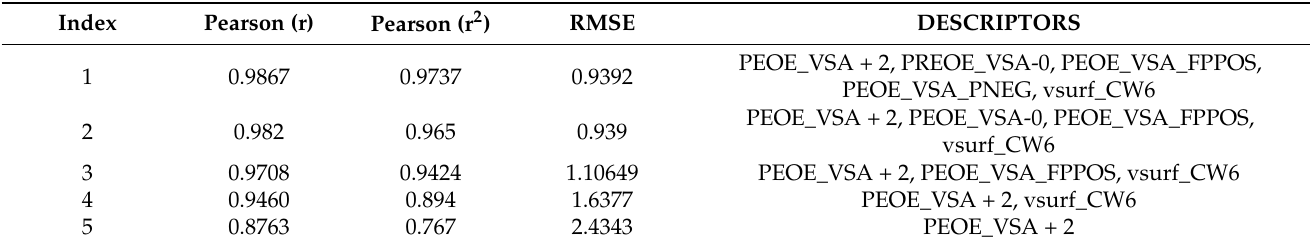
Table 8. Descriptors used in QSAR model (targeting bacterial ATP synthase) for antimicrobial activity against C. albicans .